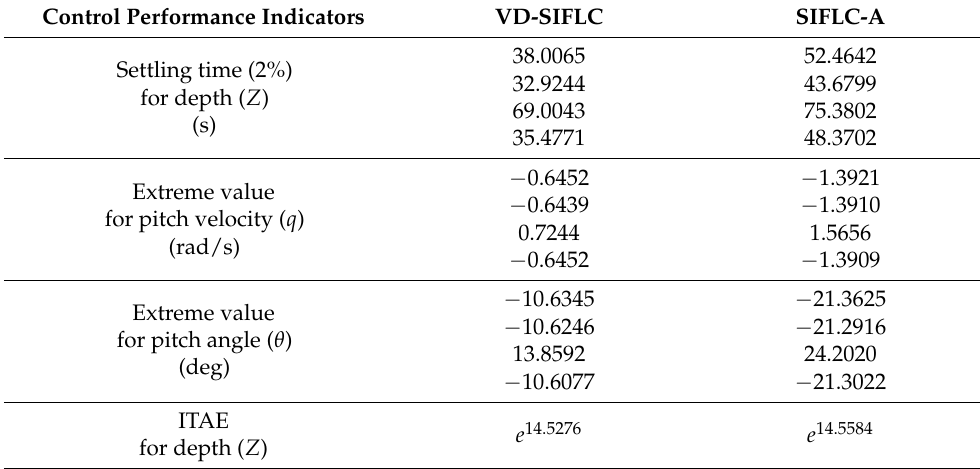
Table 6. Control performance comparison.